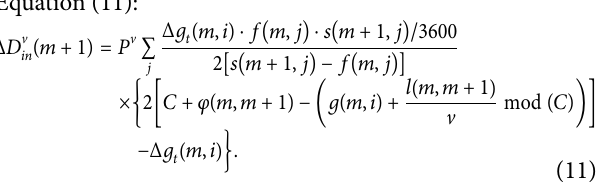
Figure 7: Analysis of nonpriority phase crossing pedestrian delay.